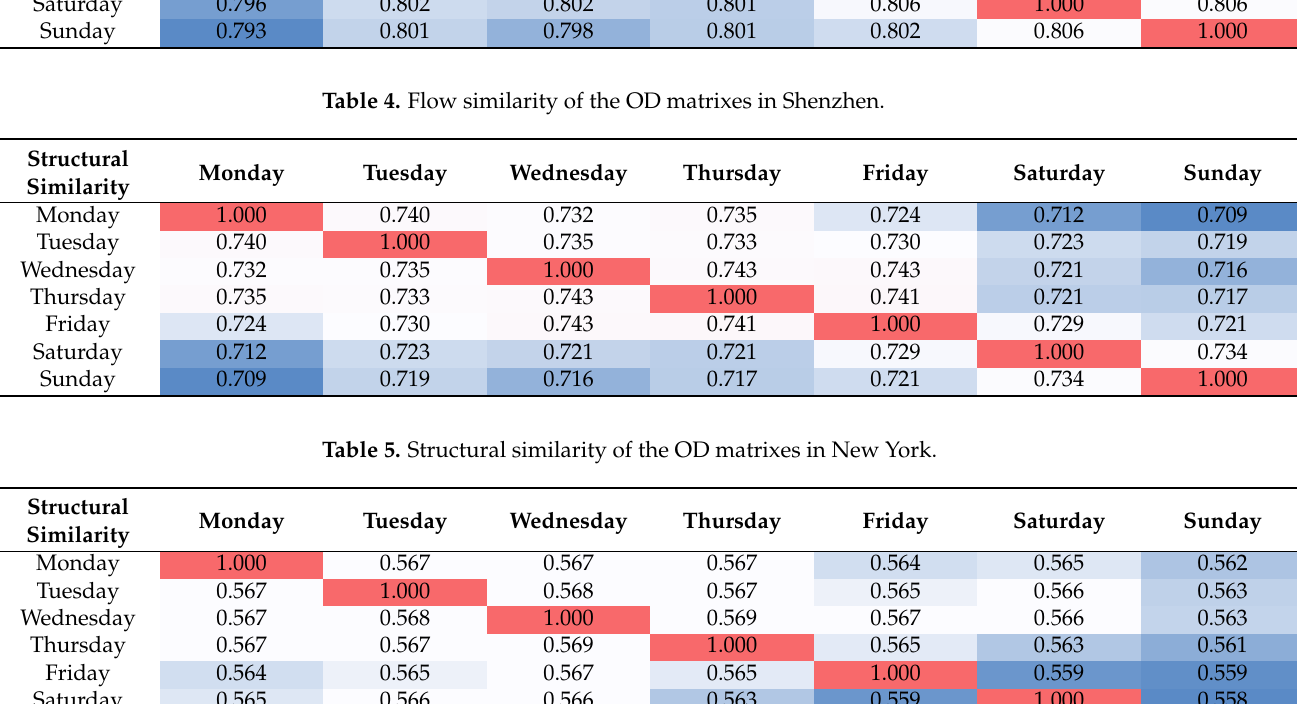
Table 4. Flow similarity of the OD matrixes in Shenzhen.